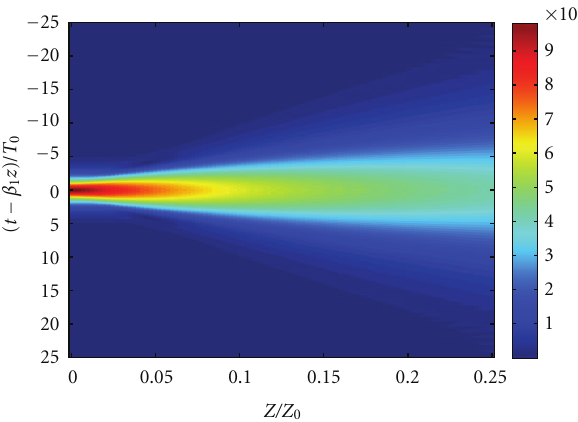
Figure 4: Temporal evolution at propagation distance of 25-cm for pump wavelength λ = 850 nm. Kerr nonlinearity, dispersion, and SRS are taken into